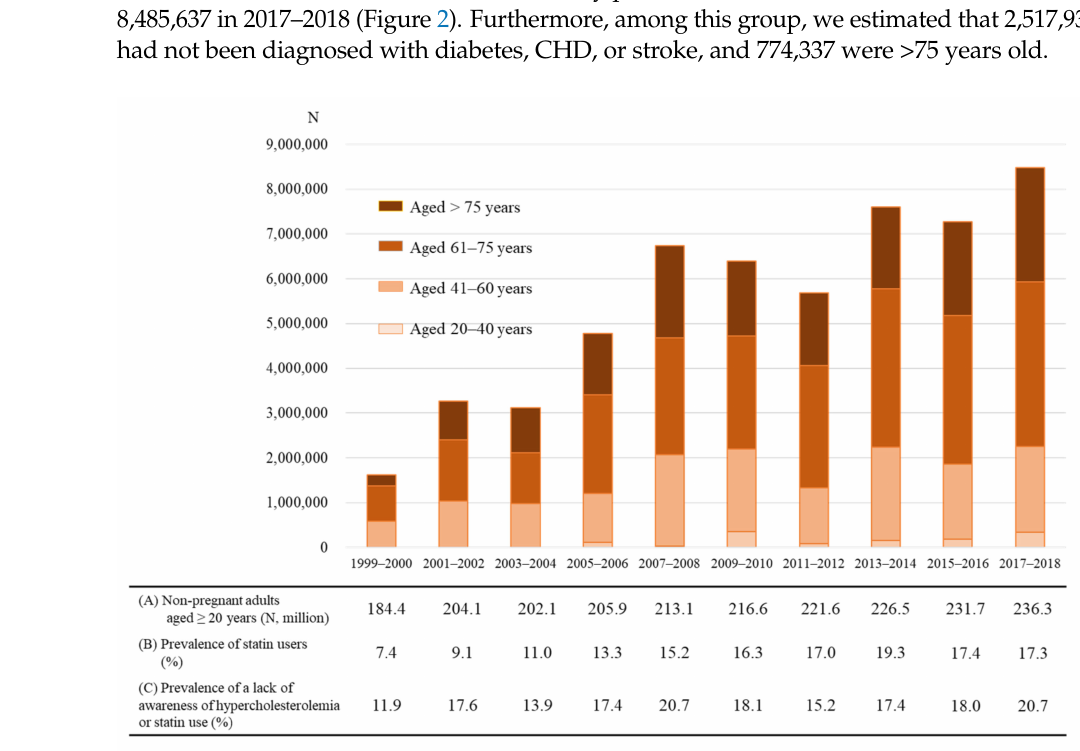
Figure 2. Trends among statin users lacking awareness of their hypercholesterolemia or statin use. The number of statin users lacking awareness of their hypercholesterolemia or statin use was estimated by multiplying ( A ) non-pregnant adults, ( B ) the number of statin users, and ( C ) the number lacking awareness of their hypercholesterolemia or statin